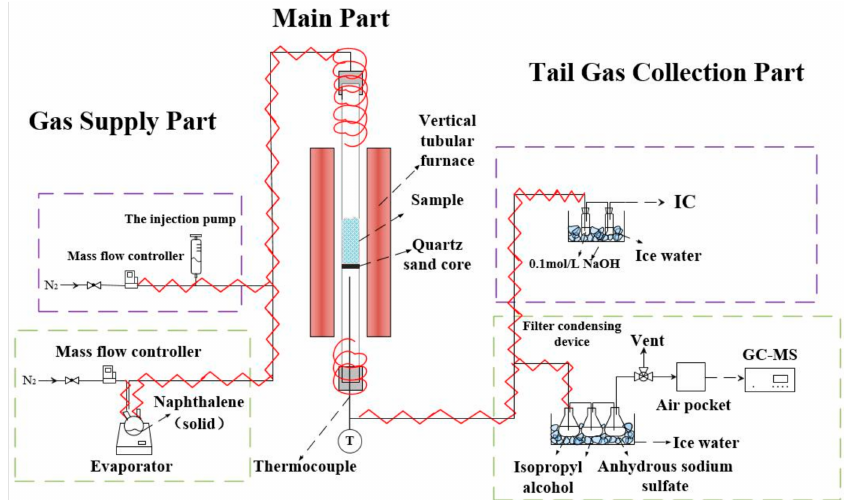
Figure 14. Simulation diagram of synthetic gas purification experiment for municipal solid